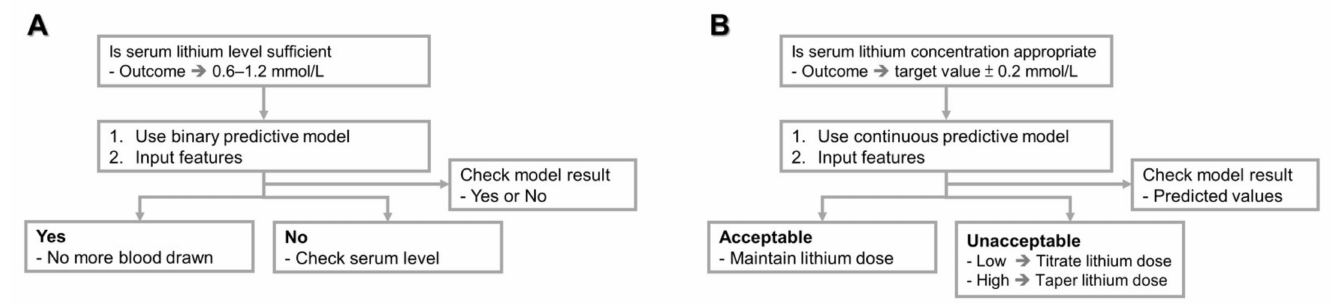
Figure 2. The suggested workflow for clinicians to use the predictive models of this study. ( A ) binary prediction, ( B ) continuous